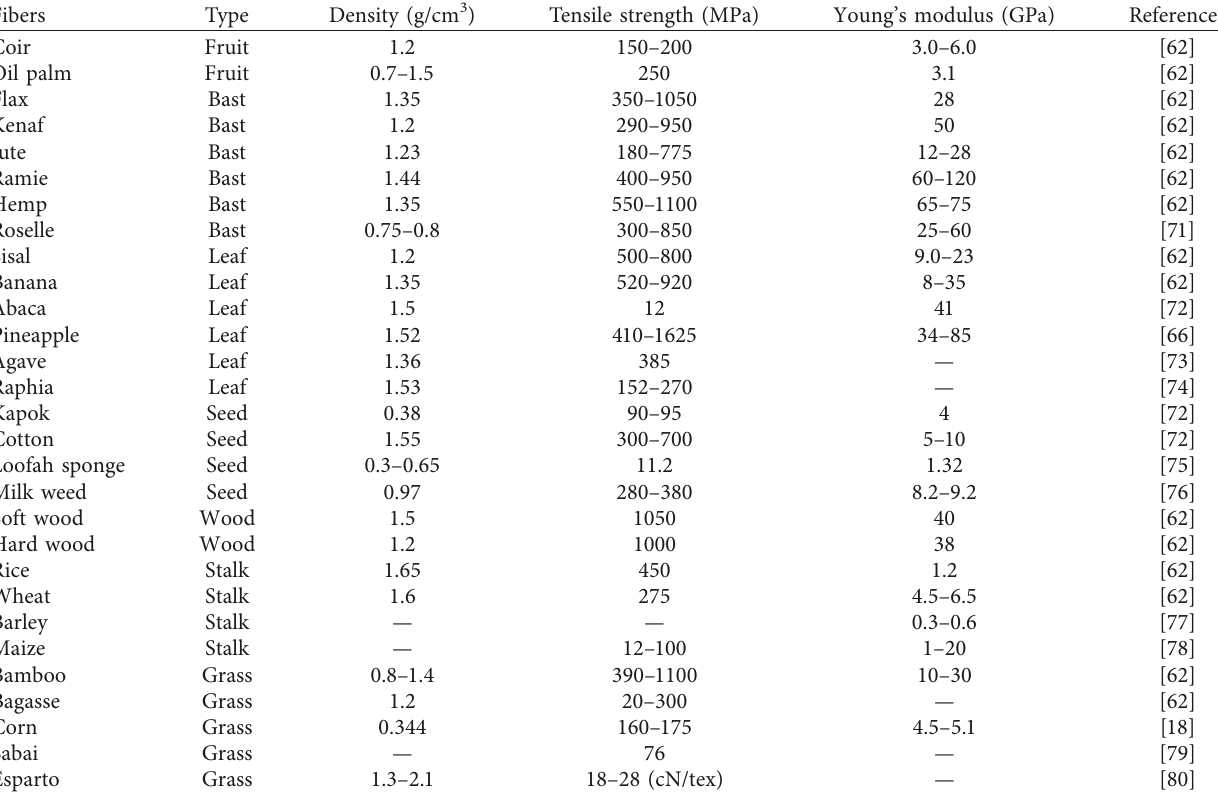
Table 10: Mechanical properties of natural